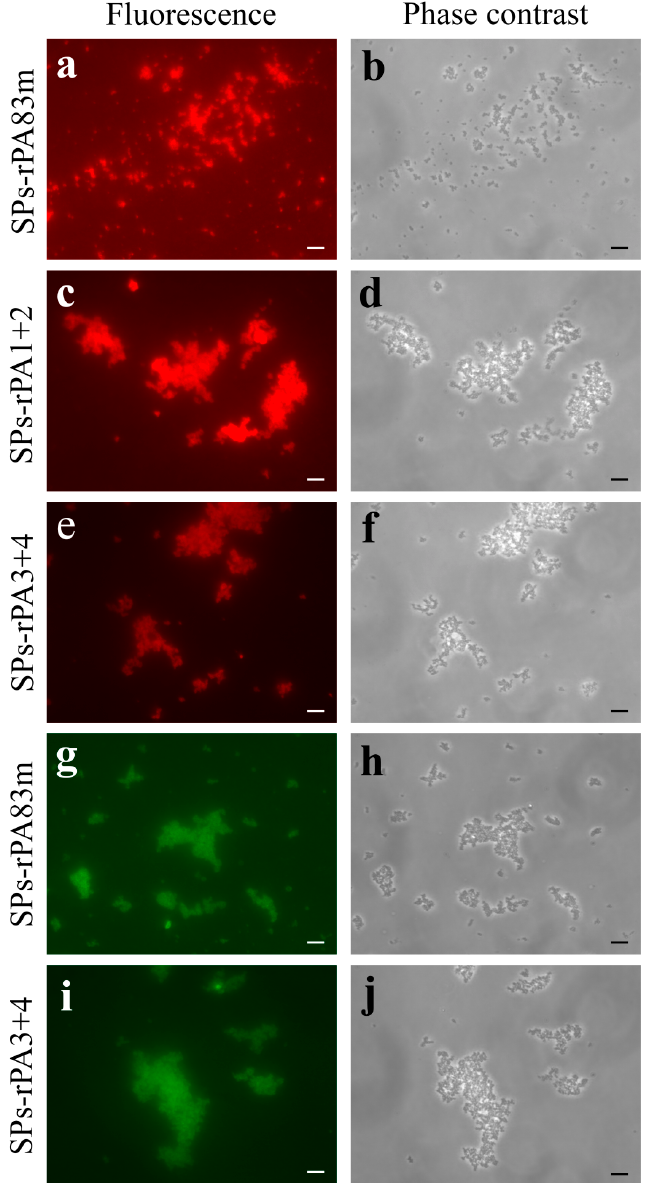
Figure 8. Antigenic specificity analysis of modified recombinant anthrax antigens within composi- tions with SPs after 40 days of incubation at +37 ° С . Immunofluorescence analysis of SPs-rPA83m